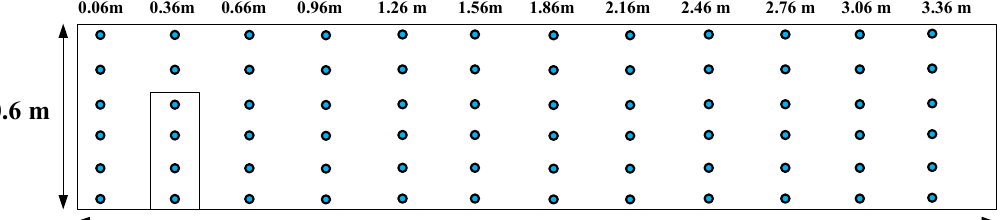
Figure 3. Arrangement of the thermocouples.